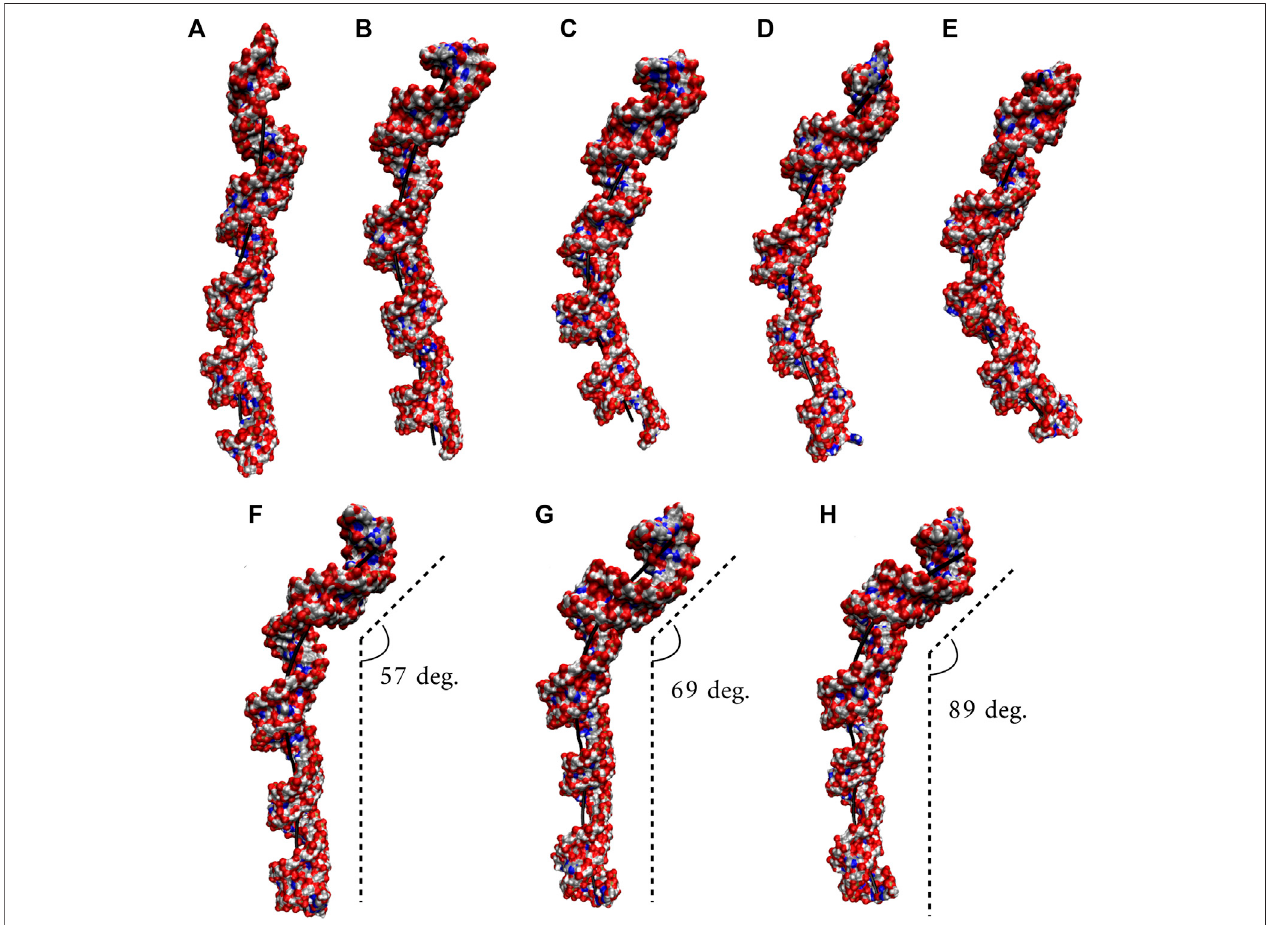
FIGURE 1 | Bent (A – E) and kink (F – H) states observed in 10×AUUCU. Each structure in A – E represents different bent states displayed in Table 2 . For example, structure A is a representative of the structures with a bending angle between 0 ° and 20 ° . No clustered state with bending angles between 20 ° and 30 ° is observed in 10×AUUCU ( Table 2 ). The curvilinear helical axis is shown as a bold black line to emphasize the curvature in each case. A kinked structure does not have a continuous curvilinear axis such as those observed in (A – E)